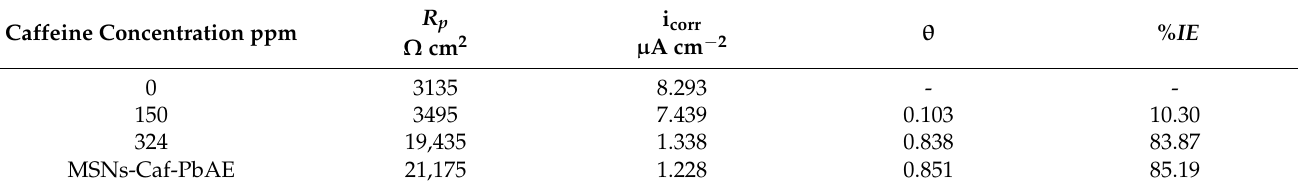
Table 3. Corrosion rate (i corr ) and inhibition efficiency (% IE ) of API X60 steel in 3.5% w / v NaCl solution, at pH = 5.0, in the presence and absence of caffeine as corrosion inhibitor and